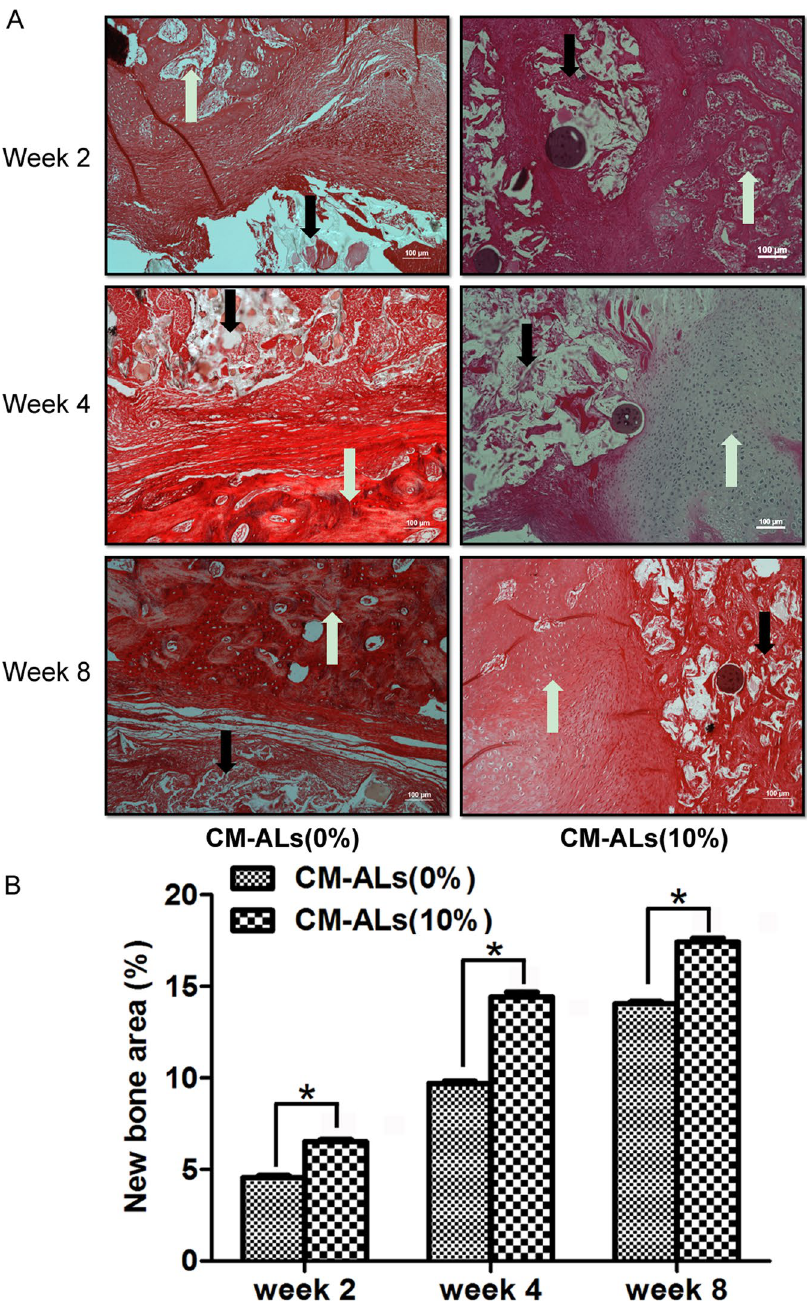
Figure 5. Histological analysis of bone regeneration and scaffold degradation at different times after implanting operation. ( A ) HE staining showing a small amount of newly formed trabeculae at 2 weeks in both CM-ALs (0%) and CM-ALs (10%) groups. At week 4 and 8, coarse bone trabeculae were presented and clustered with the vascular structure clearly seen. The fibrous tissue filled defect was still observable in the CM-ALs (0%) group, while it was less visible in the CM-ALs (10%) group; ( B ) The quantitative analysis showed the increased new bone area with the incorporated CM-ALs and increased days. White arrows indicate areas of new bone formation, while black arrows indicate the scaffolds (Magnification: × 40). * p < 0.05 vs the CM-ALs (0%) control